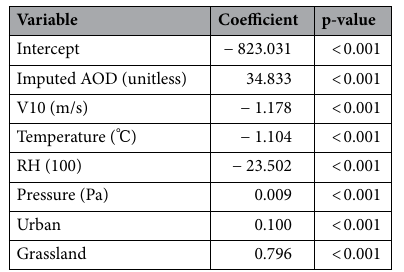
Table 2. Fixed effect terms (intercept and slope estimates) for LME model after